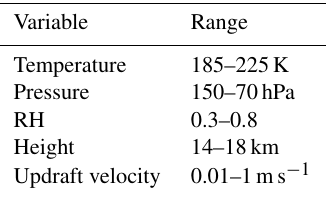
Table 1. Parameter space used to test and compare results from the new and control models.